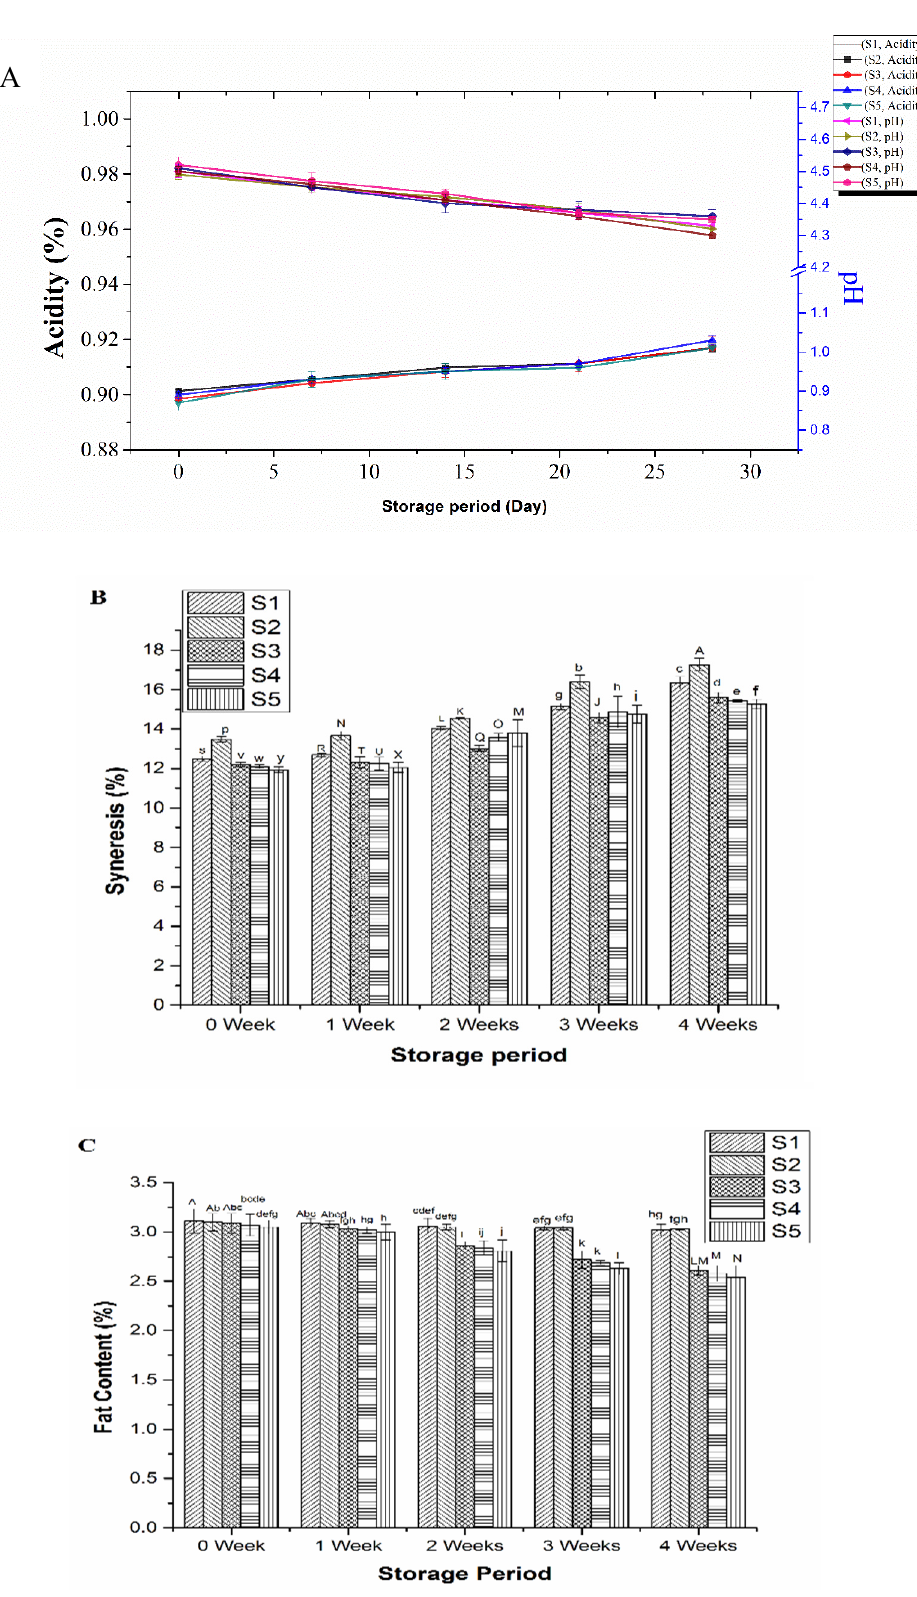
Figure 1. Change of pH and acidity ( A ), syneresis ( B ), and fat content ( C ) of the yogurt samples during storage at 4 °C for 28 days: Control plain yogurt (S1), probiotic yogurt with 0.5% S. boulardii (S2), synbiotic yogurt with 0.5% S. boulardii + 1% inulin (S3), 0.5% S. boulardii + 1.5% inulin (S4), 0.5% S. boulardii + 2% inulin (S5). Different letters denote statistical differences ( p < 0.05).